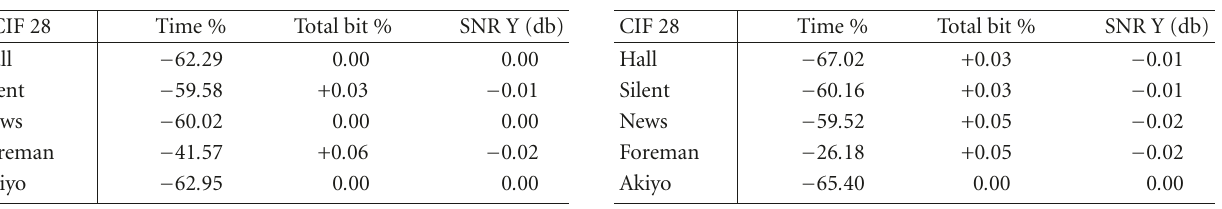
Table 1: QCIF (video image format 176 × 144), quantization